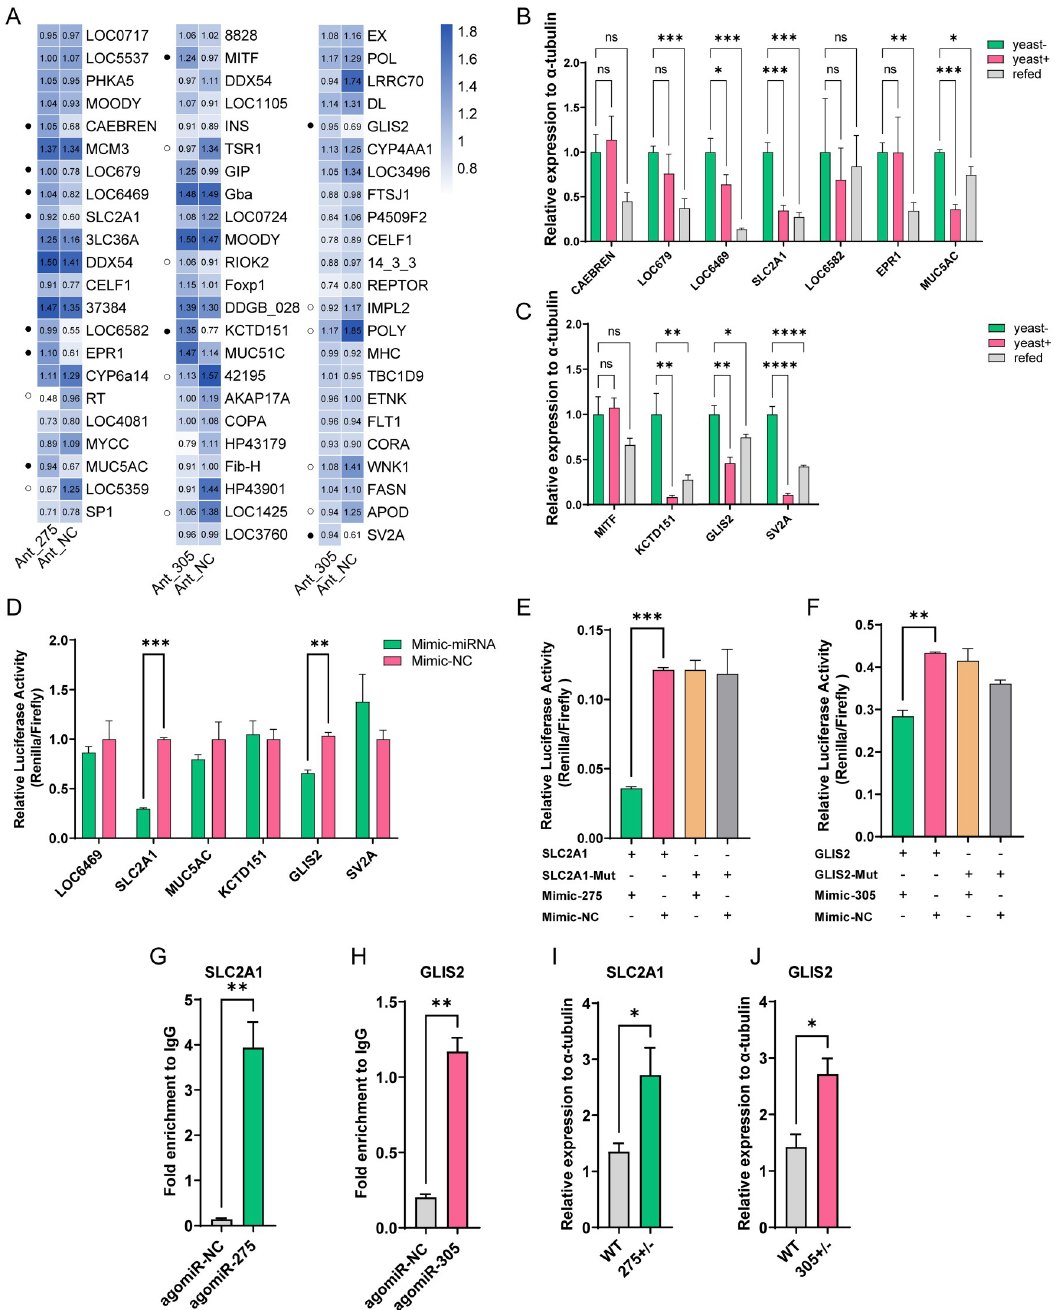
Fig 5. SLC2A1 and GLIS2 are the direct targets of miR-275 and miR-305, respectively. (A) Heatmap of relative expression levels of candidate targets in antagomiR groups (Ant-275 or Ant-305) and the negative control (Ant-NC). The number in each cell represents the mean value of the relative expression. Solid and hollow circles indicate significantly up-regulated and down-regulated target genes upon antagomiR treatment, respectively ( P < 0.05). (B-C) Validation of candidate target genes by yeast-refeeding strategy. (B) miR-275. (C) miR-305. “yeast-” and “yeast+” indicate the absence and presence of yeast in the diet for 6 days, respectively, while “refed” indicates a 4-day yeast-free diet followed by a 2-day yeast-rich diet (refed). ANOVA: � , P < 0.05; �� , P < 0.01; ��� , P < 0.001. (D) Luciferase reporter assays of candidate targets ( LOC6469 , SLC2A1 , MUC5AC , KCTD151 , GLIS2 , and SV2A ) in vitro . (E-F) Abolishment of repression effect by binding site mutation. (E) miR-275-SLC2A1 binding site mutation. (F) miR-305-GLIS2 binding site mutation. (G-H) Immunoprecipitation (RIP) of miRNA and their target genes in vivo . (G) RIP of